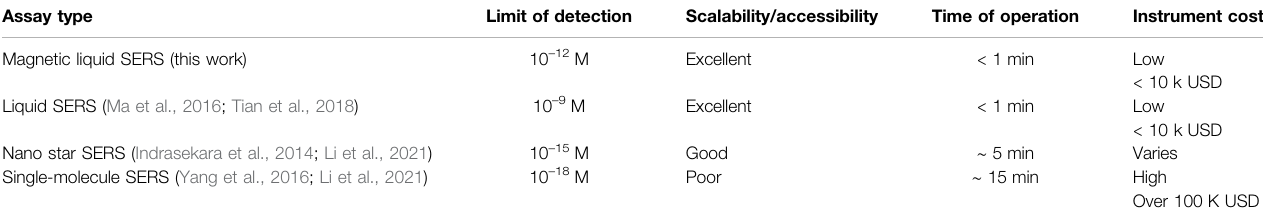
TABLE 1 | Comparison of this work with typical SERS assay in the literature. Assay